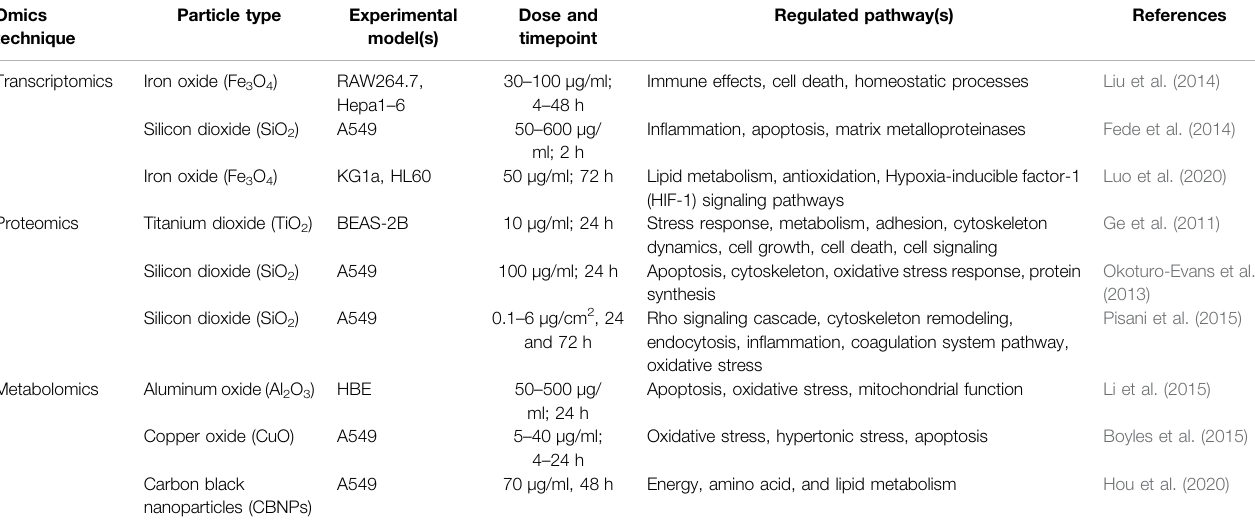
TABLE 2 | Brief overview of the in vitro studies characterizing the effects of particles on the human cell transcriptome, proteome, and metabolome. Omics